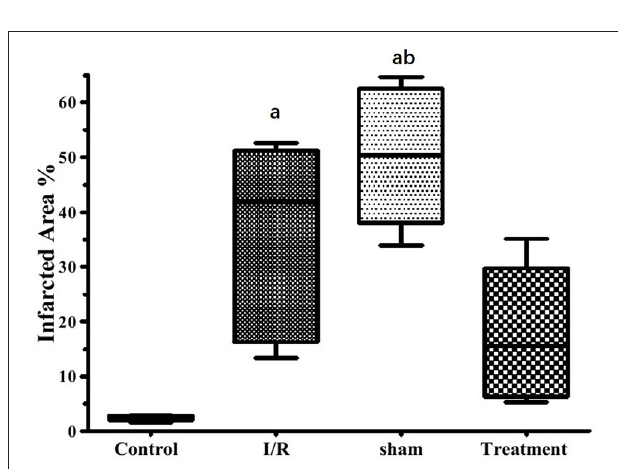
FIGURE 3 | The effects of liver remote ischemic preconditioning on I/R1-induced myocardial infarct size in the isolated perfused rat hearts. Data are obtained from at least six tested mice in each group. a = p < 0.001 vs. control, b = p < 0.001 vs. treatment. I/R, ischemia/reperfusion.